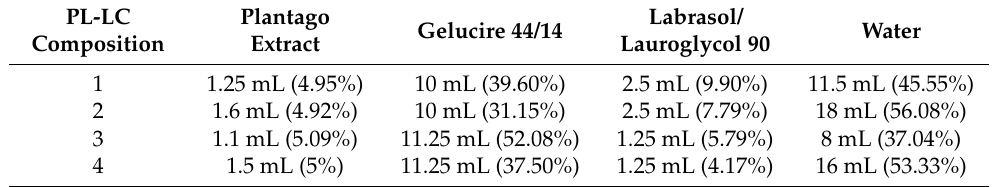
Figure 1. Pseudoternary phase diagram of the Labrasol/Lauroglycol 90 (6:1)/Gelucire 44/14/water system; the dark shaded area shows the liquid crystal (LC) zone. Component ratio of selected Plantago lanceolata (PL)-LC compositions (I–IV). Table 1. Selected compositions of liquid crystals according to the pseudoternary phase